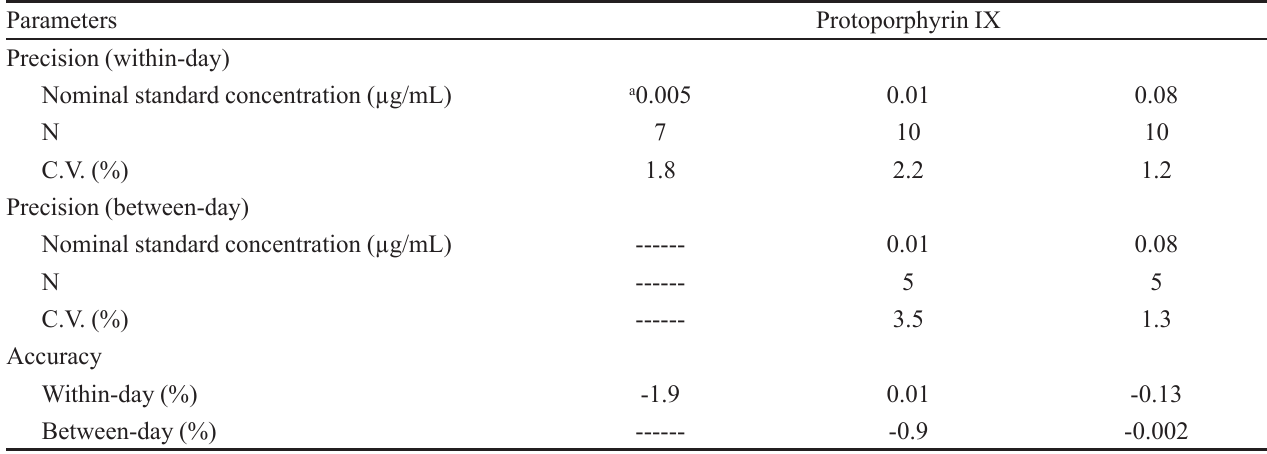
TABLE II - Analysis of the precision and accuracy of the fluorometric method for PpIX assay in phosphate buffer pH 7.2 + CPC Parameters